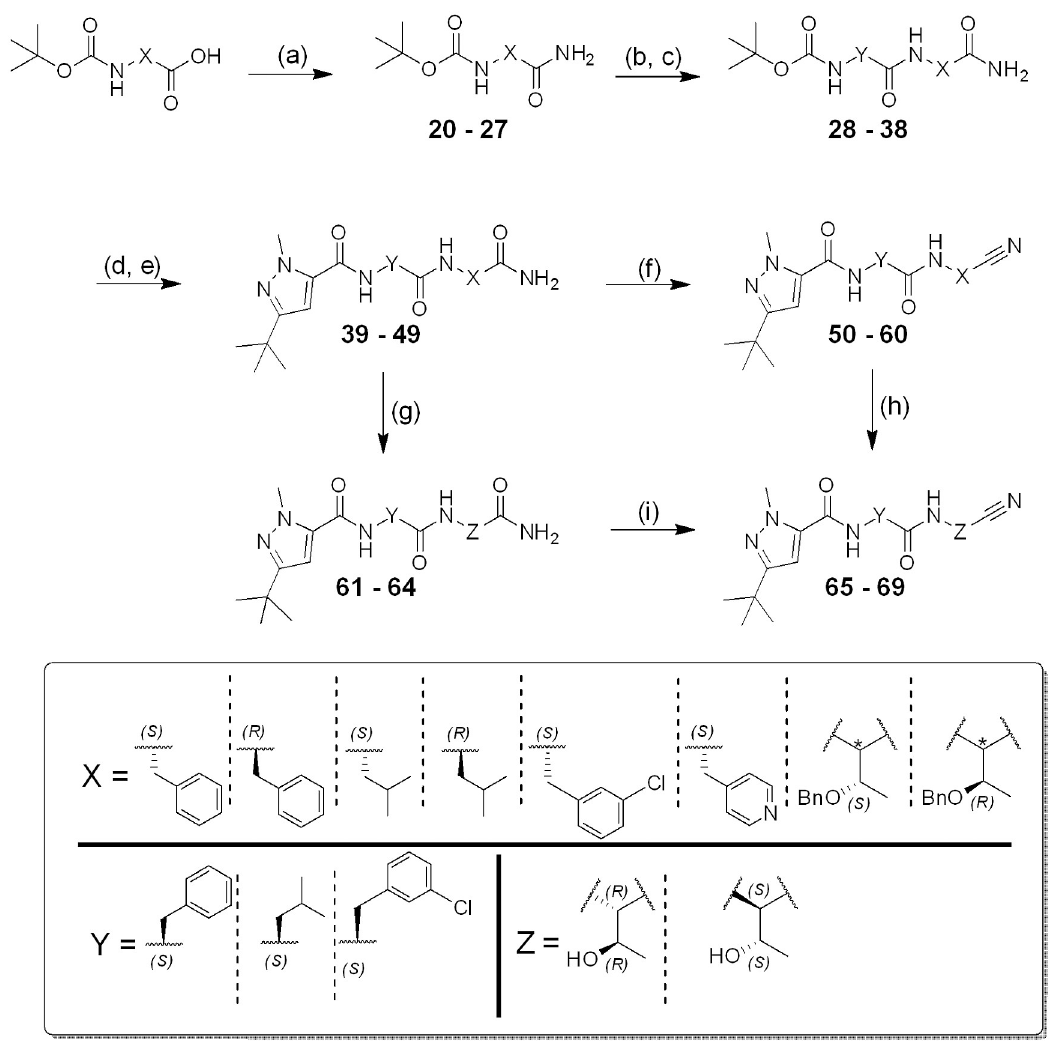
Fig 2. General synthesis of compounds 50–60, 65–69. Reagents and conditions: a) Isobutyl chloroformate, NH 4 Cl 2 M, DIPEA, DMF, 0 ˚C to rt, 20 h; b) TFA, CH 2 Cl 2 , 0 ˚C to rt, 2 h; c) HATU, DIPEA, Boc-AA-OH, DMF, rt, 18 h; d) TFA, CH 2 Cl 2 , 0 ˚C to rt, 2 h; e)TBTU, DIPEA, 3-( tert -butyl)-1-methyl-1 H -pyrazole-5-carboxylic acid, DMF/CH 2 Cl 2 , rt, 18 h; f) Cyanuric chloride, DMF, 0 ˚C to rt, 0.5 h; g) H 2 (1 atm), Pd/C, rt, 18 h; h) DDQ, CH 2 Cl 2 , rt, 3–5 days; i) TFAA, DIPEA, THF, 0 ˚C to rt, 2 h. (100 mL) was added, and it was washed with a saturated NaHCO